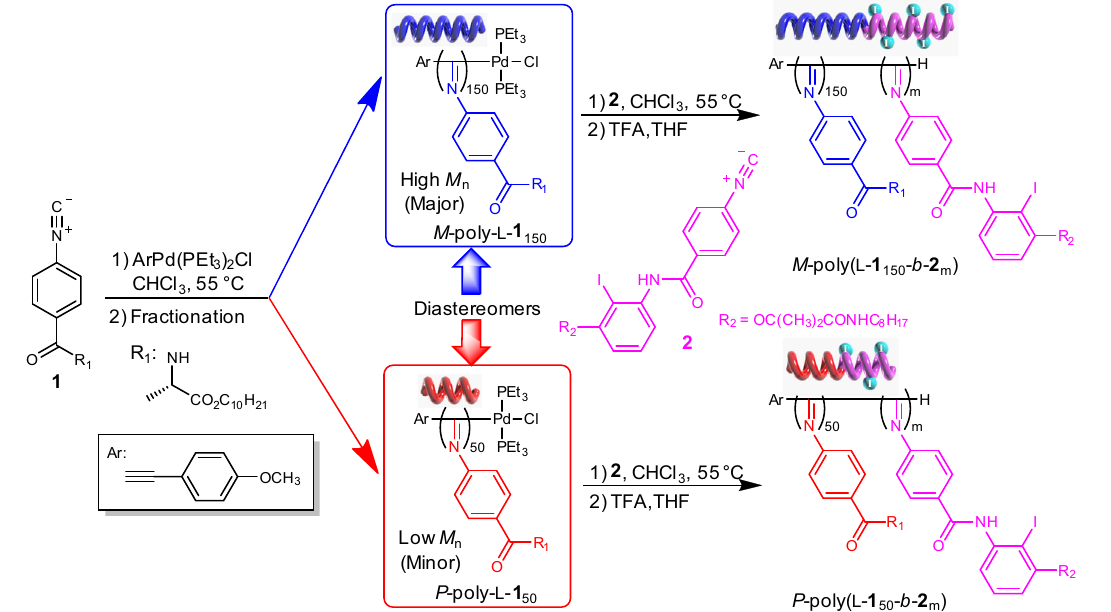
Fig. 1 | Catalysts synthesis. Synthesis of helical polyisocyanide-supported chiral catalysts.